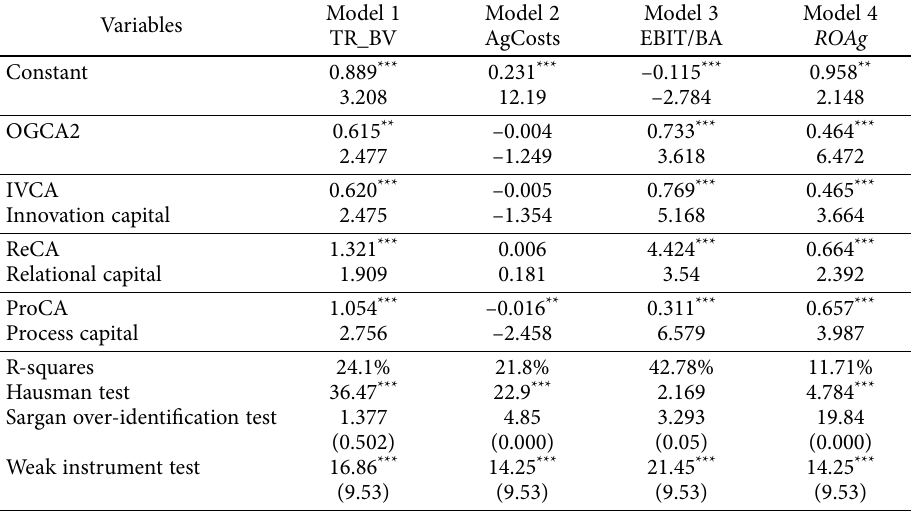
Table 6. Mediation effect between board function, organization capital and corporate